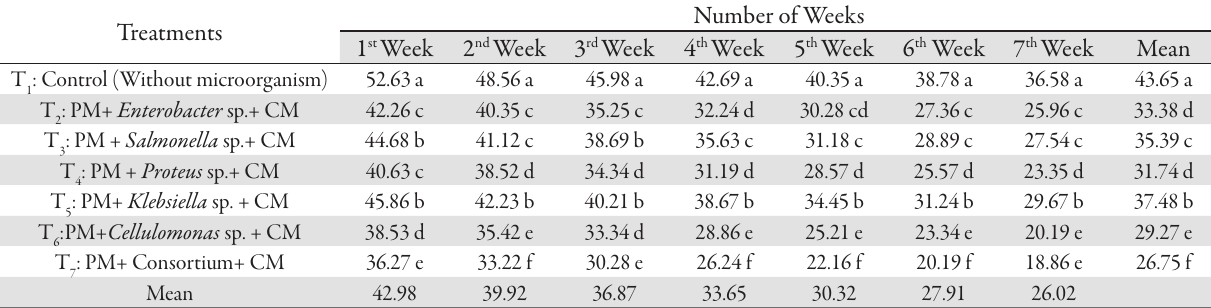
Tab. 1. Changes of organic carbon percent during composting of press mud with cattle manure Treatments